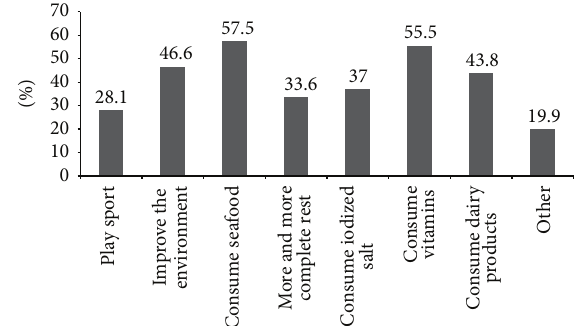
Figure4:Preventingmethodsofiodinedeficiencywiththestudents listed.